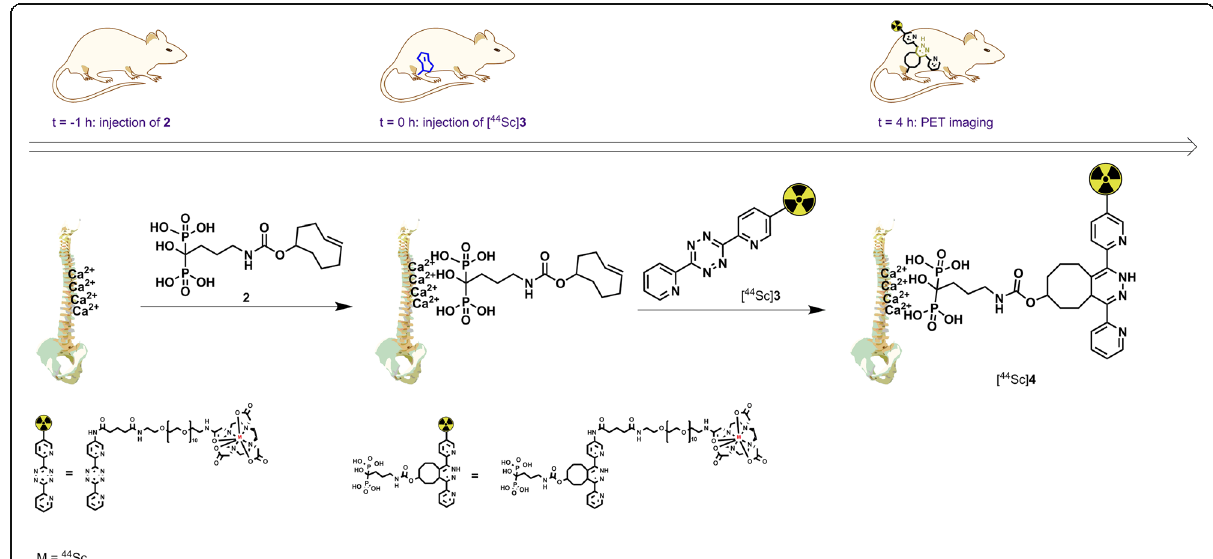
Fig. 1 Schematic of the bone-pretargeting strategy. Aln-TCO ( 2 ) is injected into healthy rats via the tail vein. After 1 h, the radiolabelled tetrazine is injected. PET imaging occurs 4 h after injecting the radiolabelled